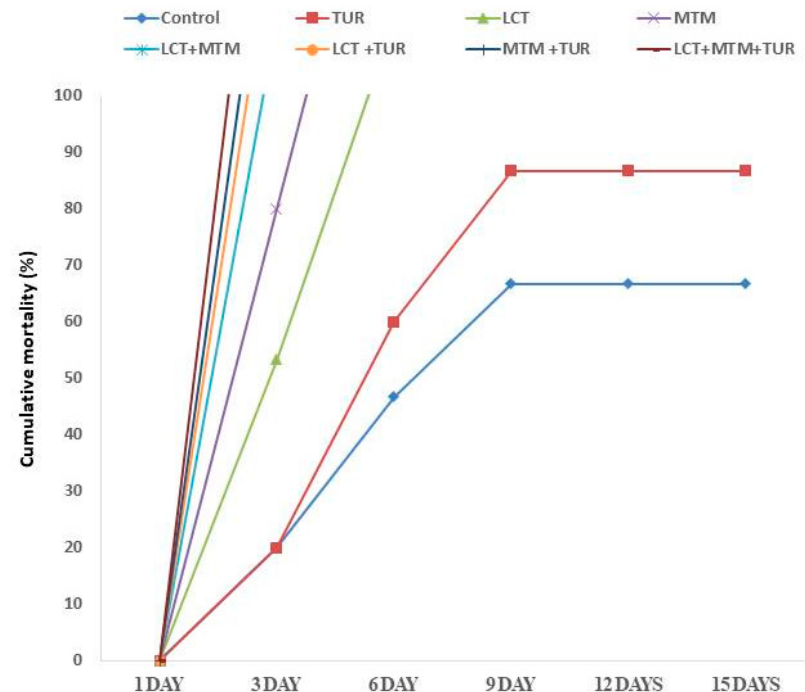
Figure 4. The cumulative mortality (%) of O. niloticus after exposure to LCT and/or MTM (1/20 of LC50), fed a diet con- taining 1% taurine (TUR) for 60 days. Each line represents a group’s cumulative mortality (%) from days 1 to 15 post- challenge by A. hydrophila